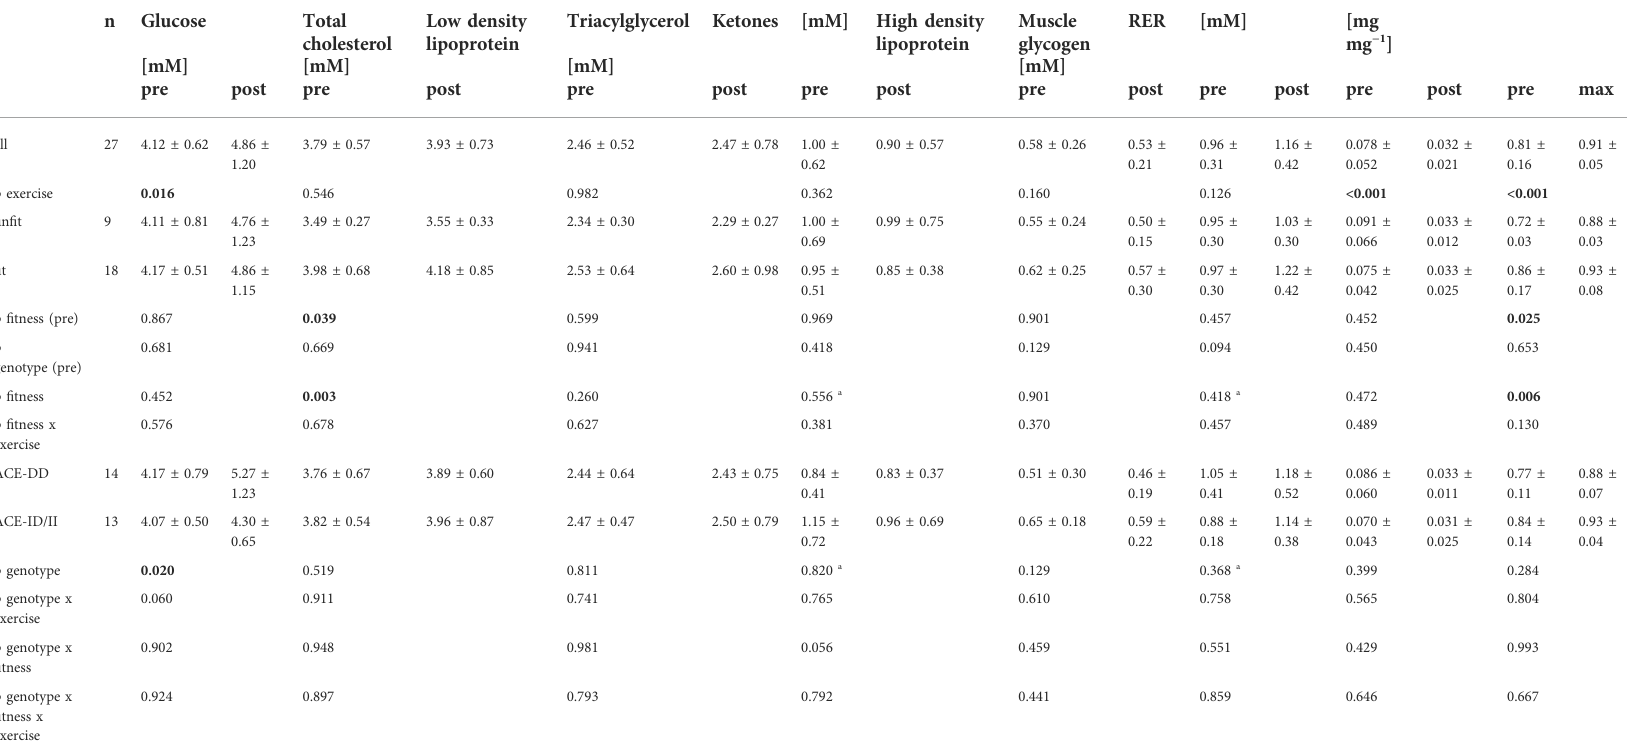
TABLE 2 Metabolic